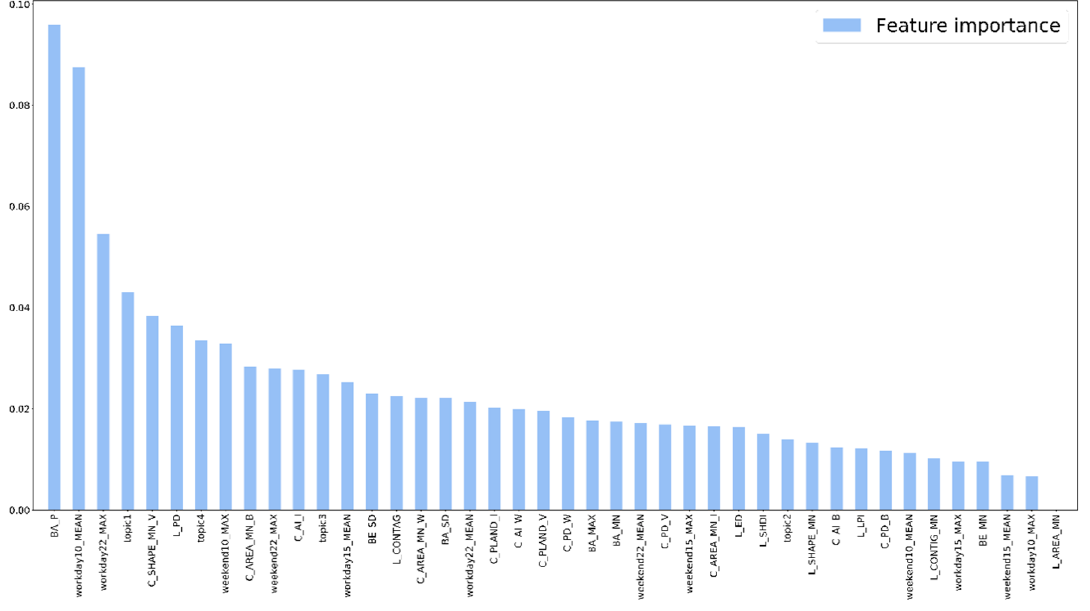
Figure 9. Importance ranking of features.